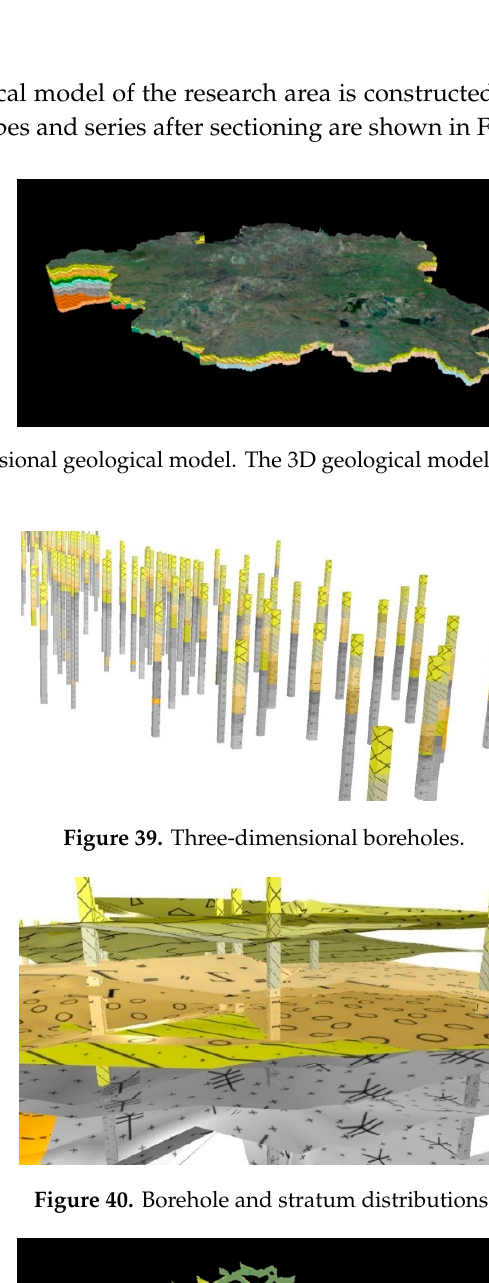
Figure 37. Workflow of 3D geological modeling.